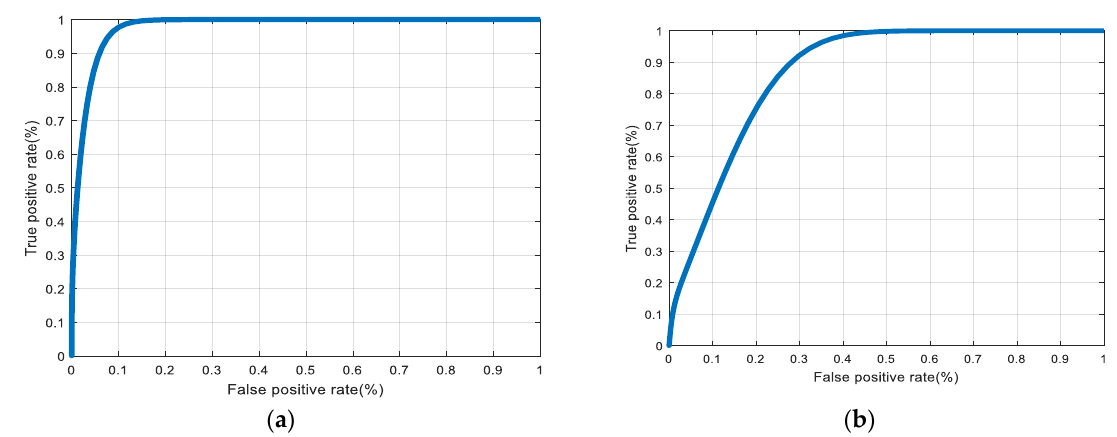
Figure 19. ROC curves for the system using an encrypted kernel with the IWT with different keys of encryption with a noise variance of ( a ) 0.01, and ( b ) 0.02.